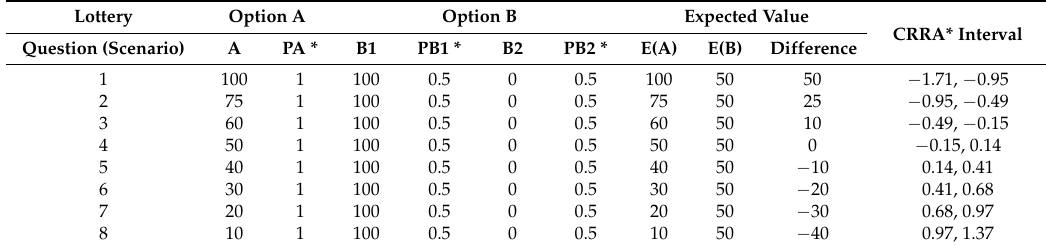
Table 6. Matrix of payments in the risk aversion